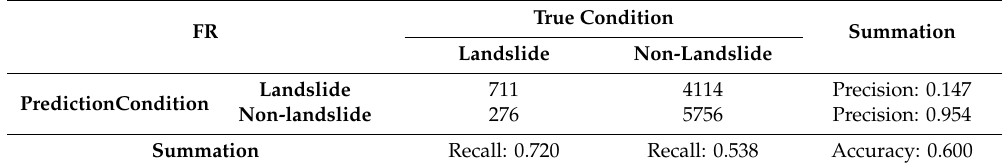
Table 9. Confusion matrix of FR.